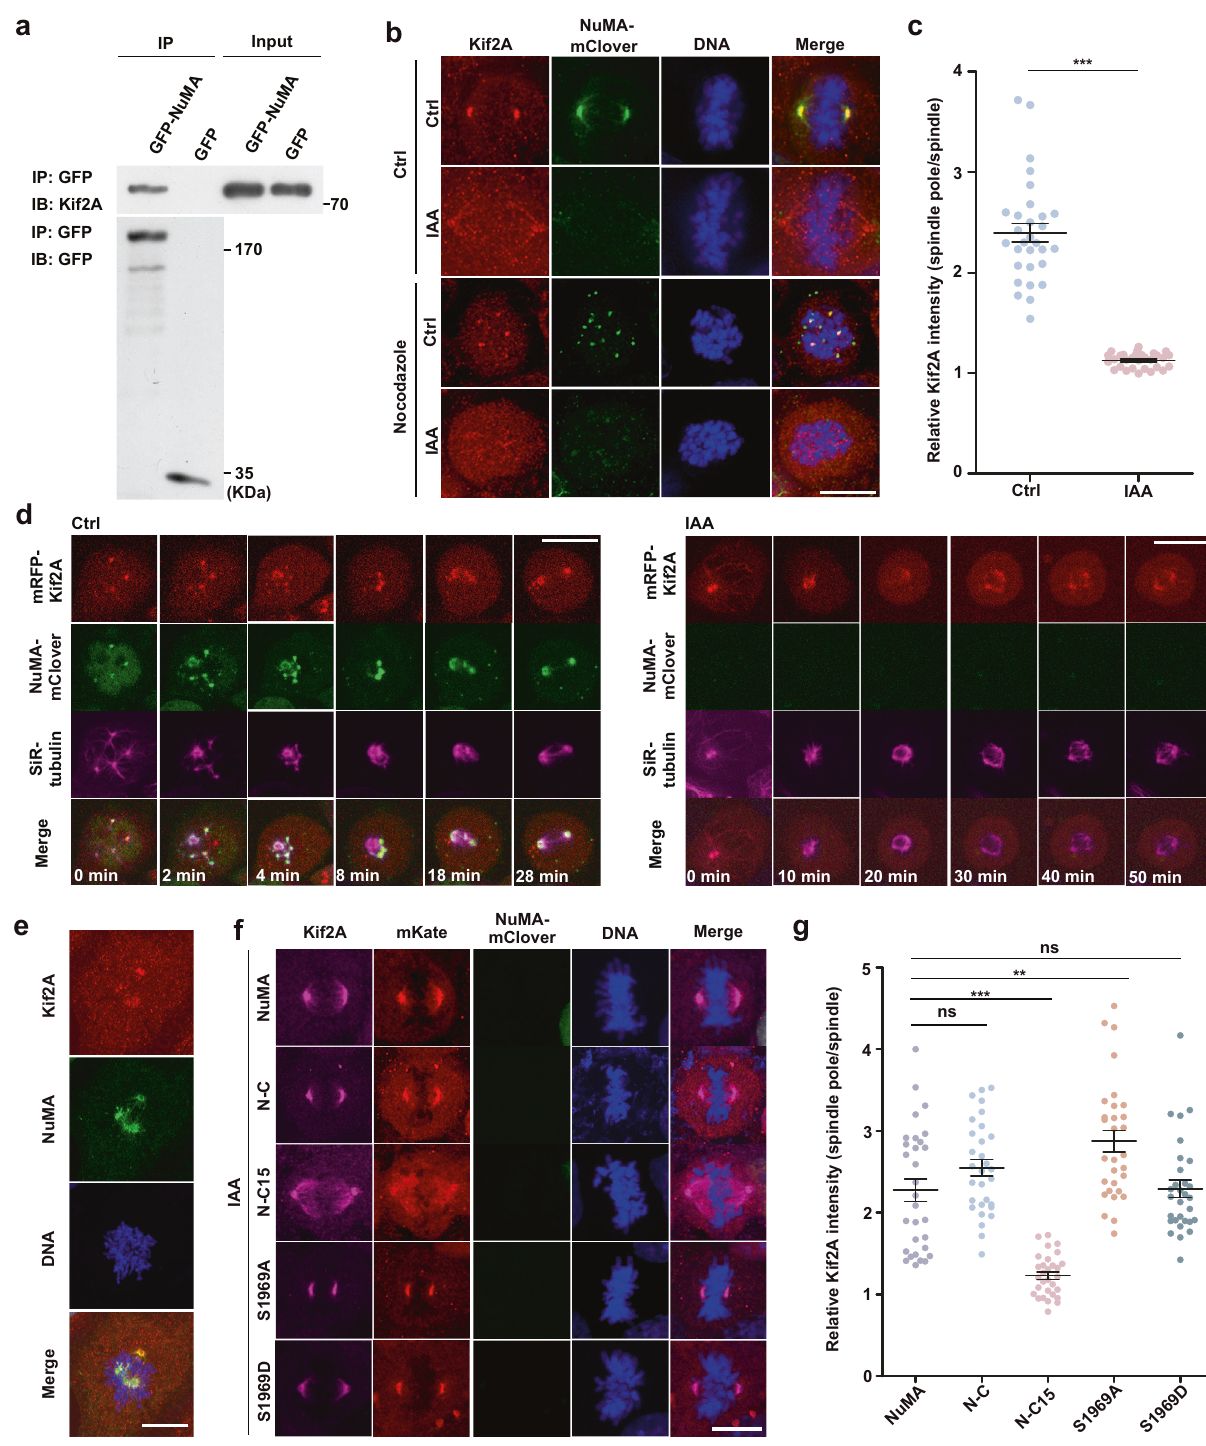
that an abundant nuclear protein NuMA plays a crucial role at the spindle poles for spindle assembly, structural dynamics, and function through cell cycle-regulated phase separation. This work provides not only a previously uncovered principle of the bipolar spindle assembly and dynamics regulated by phase separation of NuMA and enrichment of key regulators for poleward spindle microtubule fl ux by NuMA droplets but also an important clue to study insight of the mechanisms for accurate chromosome con- gression and segregation for faithful cell